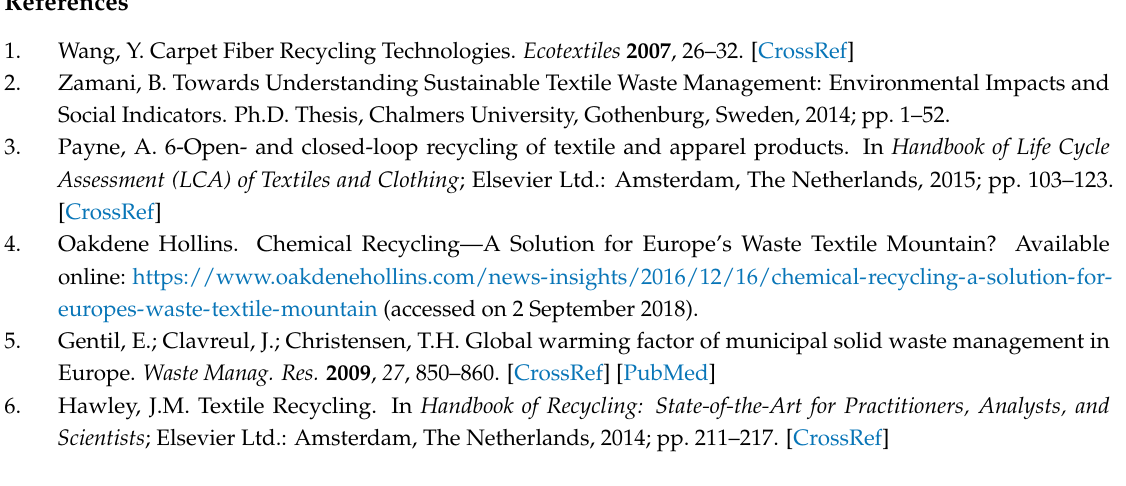
s1, Figure S1: Recovery of protein and cellulose fibers building blocks after sequential treatment; Figure S2 and S3: Protease volumetric assay; Figure S4: SDS-Page of the samples after protease treatment; Figure S5: Amino groups content from wool hydrolysate supernatants; Figure S6: FT-IR spectra of the recovered PET materials; Figure S7: Weight % recovered